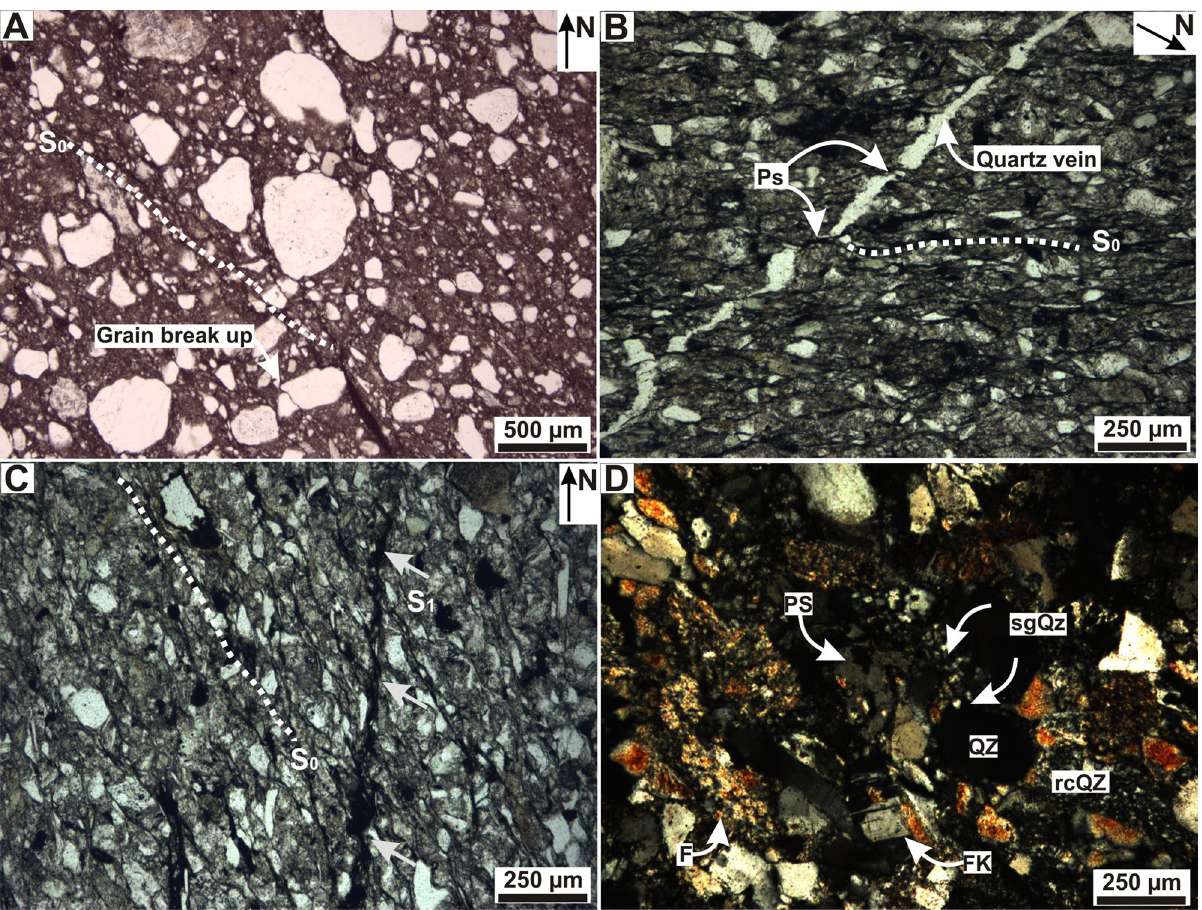
Figure 3. ( A ) Micro-photograph under transmitted light of Sauce Grande Formation. Broad foliation plane (S 0 ), braided to parallel shape and penetrative, represent by the phyllosilicates and the opaque minerals (white arrows), with associated grain break up. Micro-photograph of the Piedra Azul Formation. ( B ) Primary foliation (S 0 ) represented by phyllosilicates (micas), oxides and veins; quartz veins orientated at 45° with the S 0 and showing dissolution be pressure (Ps). ( C ) S 0 and second week foliation plane S 1 represented by micas and opaque minerals, under transmitted light with parallel nicols. ( D ) Microlithons composed by grains of quartz (Qz) and feldspar (FK), pressure shadows (PS), subgrains in quartz (sgQz) and quartz re-crystallization (rcQz), folia (F) composed by micas, recrystallized quartz, opaque minerals, and epidote, under transmitted light with crossed nicols. The micro-photographs are orientated respect to the north